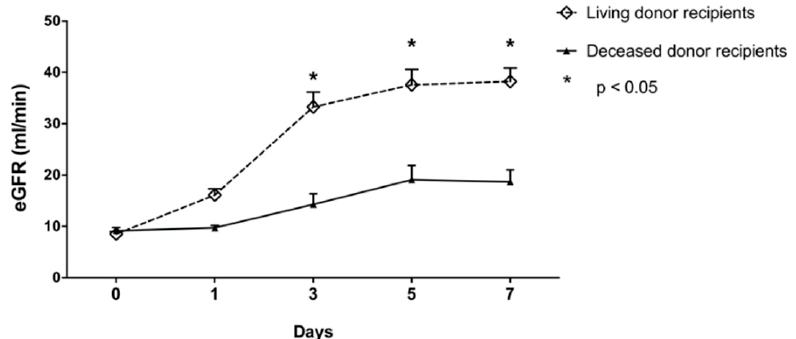
Figure 2. eGFR comparison between deceased and living donor recipients before and during the first week after transplantation.